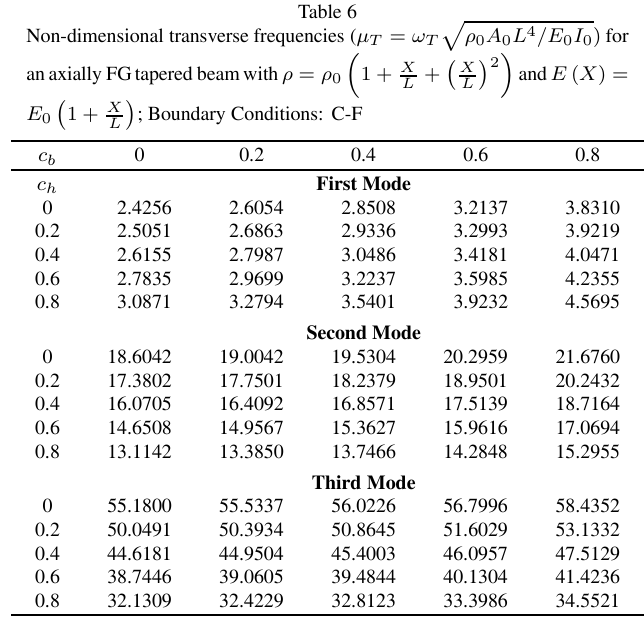
(cid:27) Table 7 ρ 0 A 0 L 4 /E 0 I 0 )